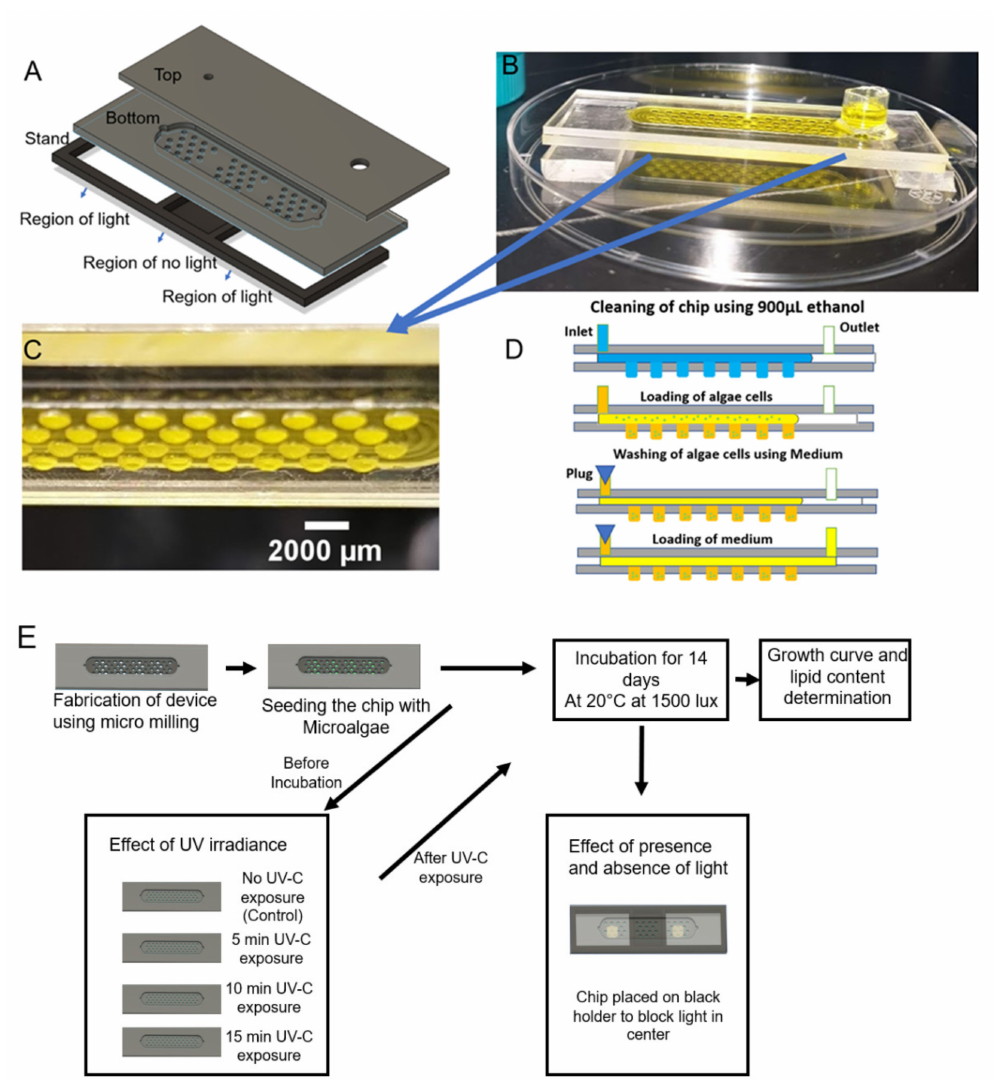
Figure 1. Illustration of the chip design. ( A ) Layout of a chip used to study the effect of light. The chip holder consists of three regions, two of which were exposed to light and one was an unexposed region. ( B ) Image of an actual assembled chip. ( C ) A chip filled with yellow dye shows the formation of a hanging drop formed on the bottom of the chip through the well (scale = 1 mm). ( D ) Schematic illustration of the hanging-drop chip operation. ( E ) Schematic diagram to summarize the experimental